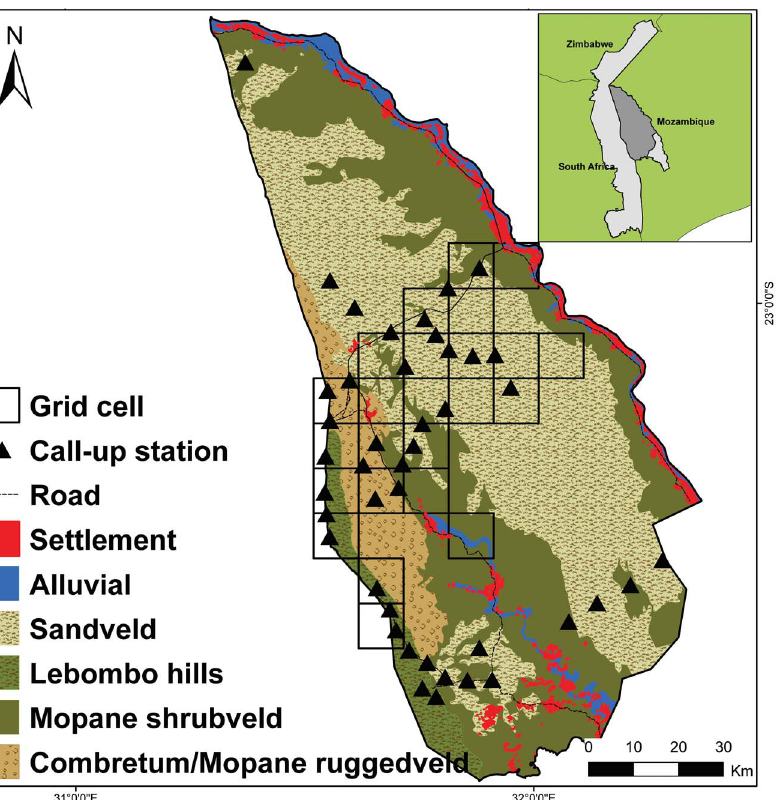
Figure 1. Survey effort in the Limpopo National Park (LNP), Mozambique. LNP is bounded to the west by the Kruger National Park in South Africa, characterized by formal protection and high wildlife densities, and to the east by the Limpopo River, characterized by agro-pastoralist settlements. Surveyed grid cells (100 km 2 ) and call-up stations shown overlaid across a gradient of landscape types and human impact. Inset map: Location of LNP (dark grey) in relation to the Greater Limpopo Trans-frontier Park (light grey), including the region to the south of LNP which has been recently seperated by a wildlife barrier fence, and to Zimbabwe and South Africa.